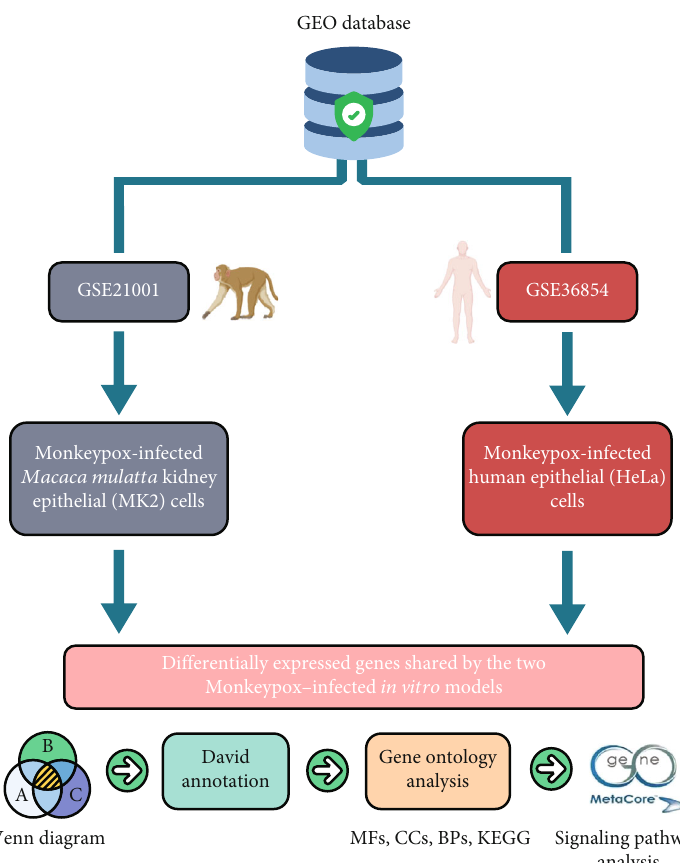
Figure 1: Schematic illustration of the study design. High-throughput data of monkeypox-infected 7-hours of Macaca mulatta kidney epithelial (MK2) cells and monkeypox-infected 6-hours of human immortal epithelial cancer (HeLa) cells were both acquired from the GEO database. The top 5% of di ff erentially expressed genes in the two monkeypox-infected models were determined through a Venn diagram analysis. Results of pathway analyses and functional interpretations were analyzed using DAVID, GO, STRING, and